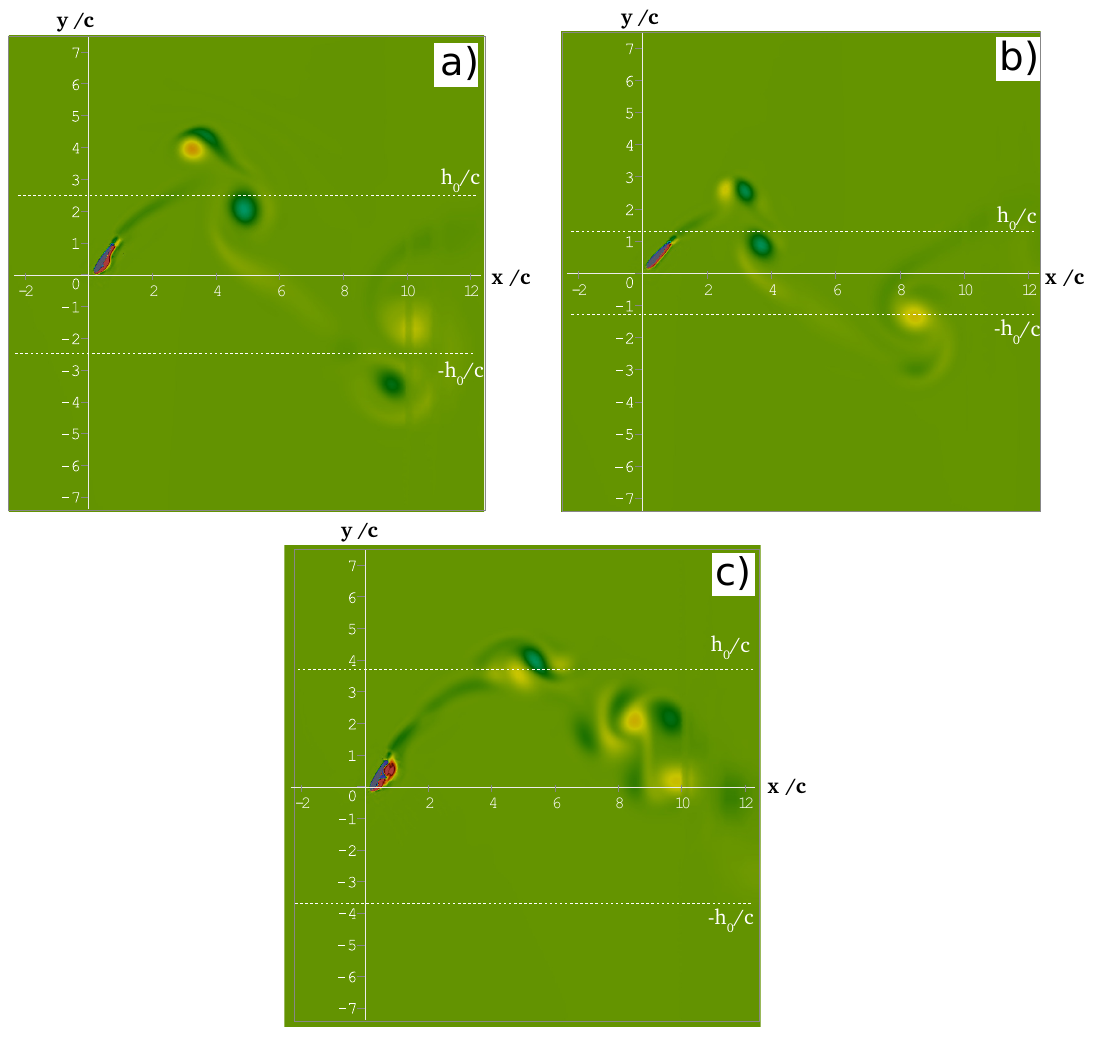
Figure 6. Vorticity field, B = 0.4 for different times: ( a ) for h 0 / c = 2.5, t = 239 s; ( b ) h 0 / c = 1.25, t = 239 s ; ( c ) h 0 / c = 3.75, t = 235. Red to blue color scale represents positive to negative